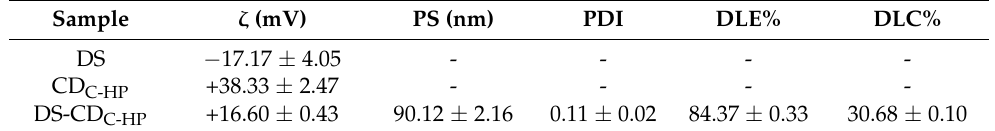
Table 1. Zeta potential ( ζ ), Particle size (PS) and particle size distribution index (PDI),